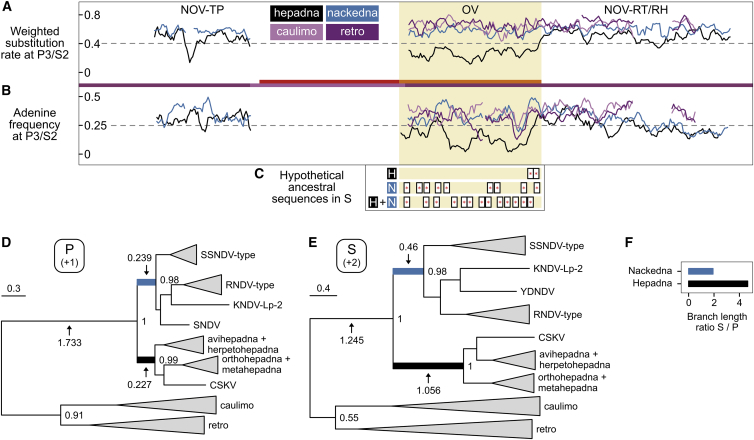
De Novo Emergence of PreS/S in Hepadnaviruses(A) Weighted substitution rates at codon position 3 in the P frame, which equals codon position 2 in the S frame (P3/S2) for conserved regions in TP, RT, and RH. RT/S overlap region (OV) in hepadnaviruses highlighted by light-yellow background. NOV, non-overlapping regions.(B) Adenine frequencies at P3/S2 positions.(C) Hypothetical ancestral sequences for the overlap region reconstructed for the ancestors of hepadnaviruses (H), nackednaviruses (N), and hepadna- and nackednaviruses (H + N). Predicted stop codons in the S frame are highlighted.(D) Phylogeny for the RT/S overlap region translated in the P frame. Scale bar, substitutions per site. Branches representing the relevant time window after the split between nackedna- and hepadnaviruses and before the first intragroup speciation events are colored and their lengths are indicated.(E) Phylogeny for the RT/S overlap region translated in the S frame.(F) Ratio of analogous branches in the P and S frame-based phylogenies for the RT/S overlap, estimating the relative evolutionary change in the S frame between viral lineages.